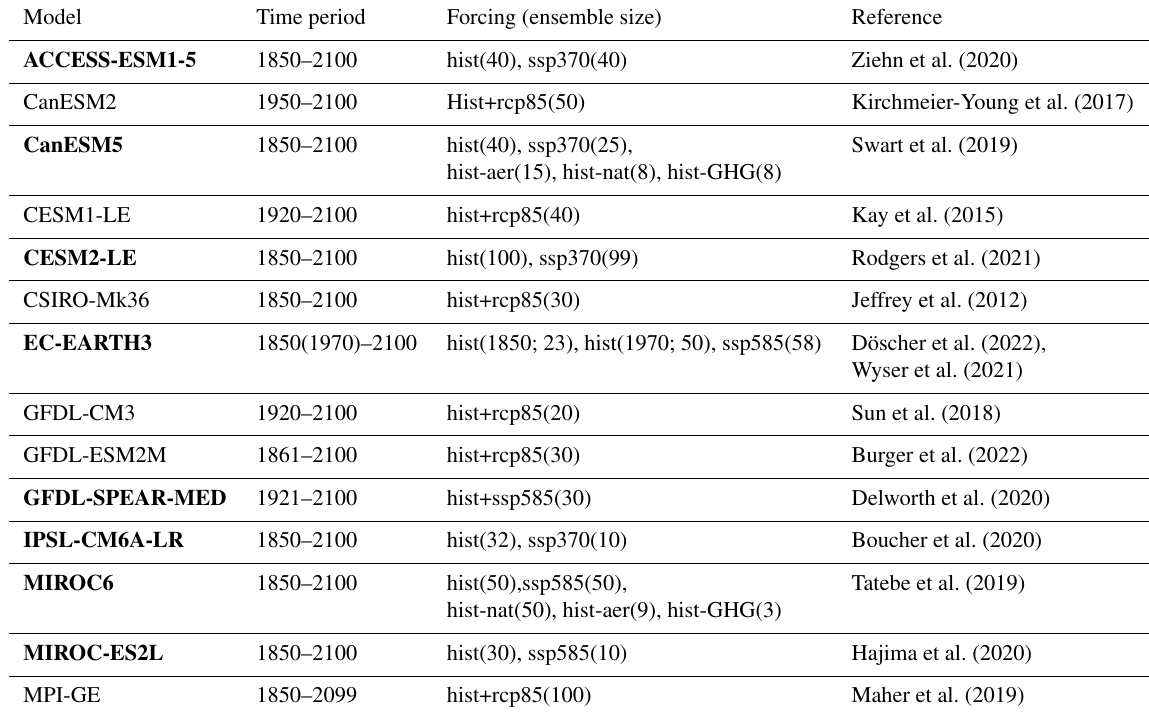
Table 1. SMILEs used in this study. CMIP6 models are highlighted in bold